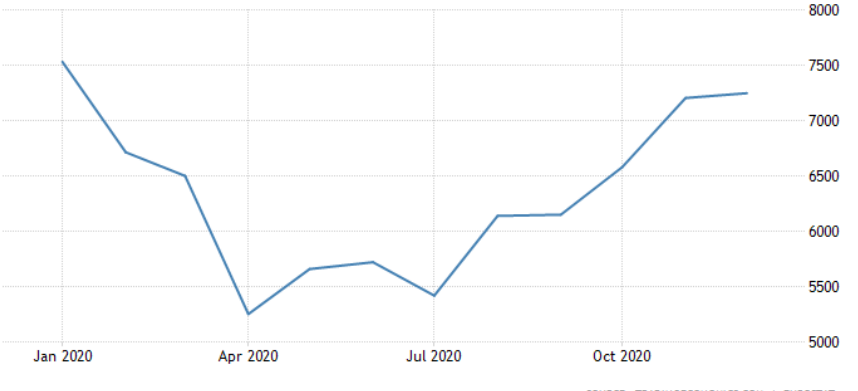
Figure 1. The monthly electricity production in Gigawatt-hours during the period 1 January 2020 until 1 January 2021 the in Czech